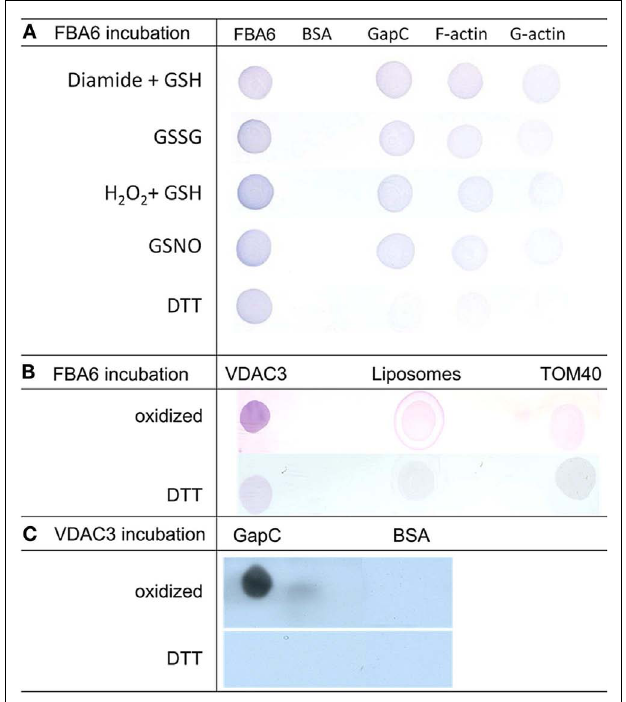
FIGURE 8 | Homology modeling of 3D-structures of aldolase, GAPDH, and actin . On the left hand side, the proteins from rabbit as used by Forlemu et al. (2011) are shown.The corresponding Arabidopsis proteins on the right hand side were modeled with SWISS-MODEL as described in Section Experimental Procedures. By using the Swiss-PdbViewer 4.0.4, the molecular surface of the generated protein models was calculated and the conserved amino acids which are necessary for the protein–protein interaction are colored: Positively charged amino acids are blue, negatively charged amino acids are red. Cysteines are shown in